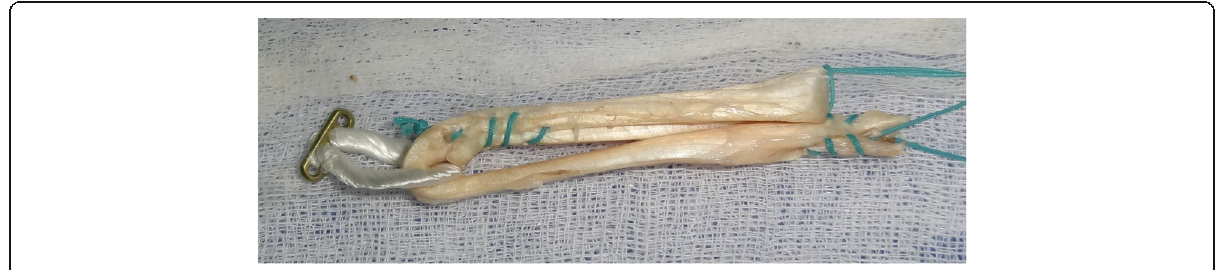
Fig. 2 Tripled graft configuration in Group III